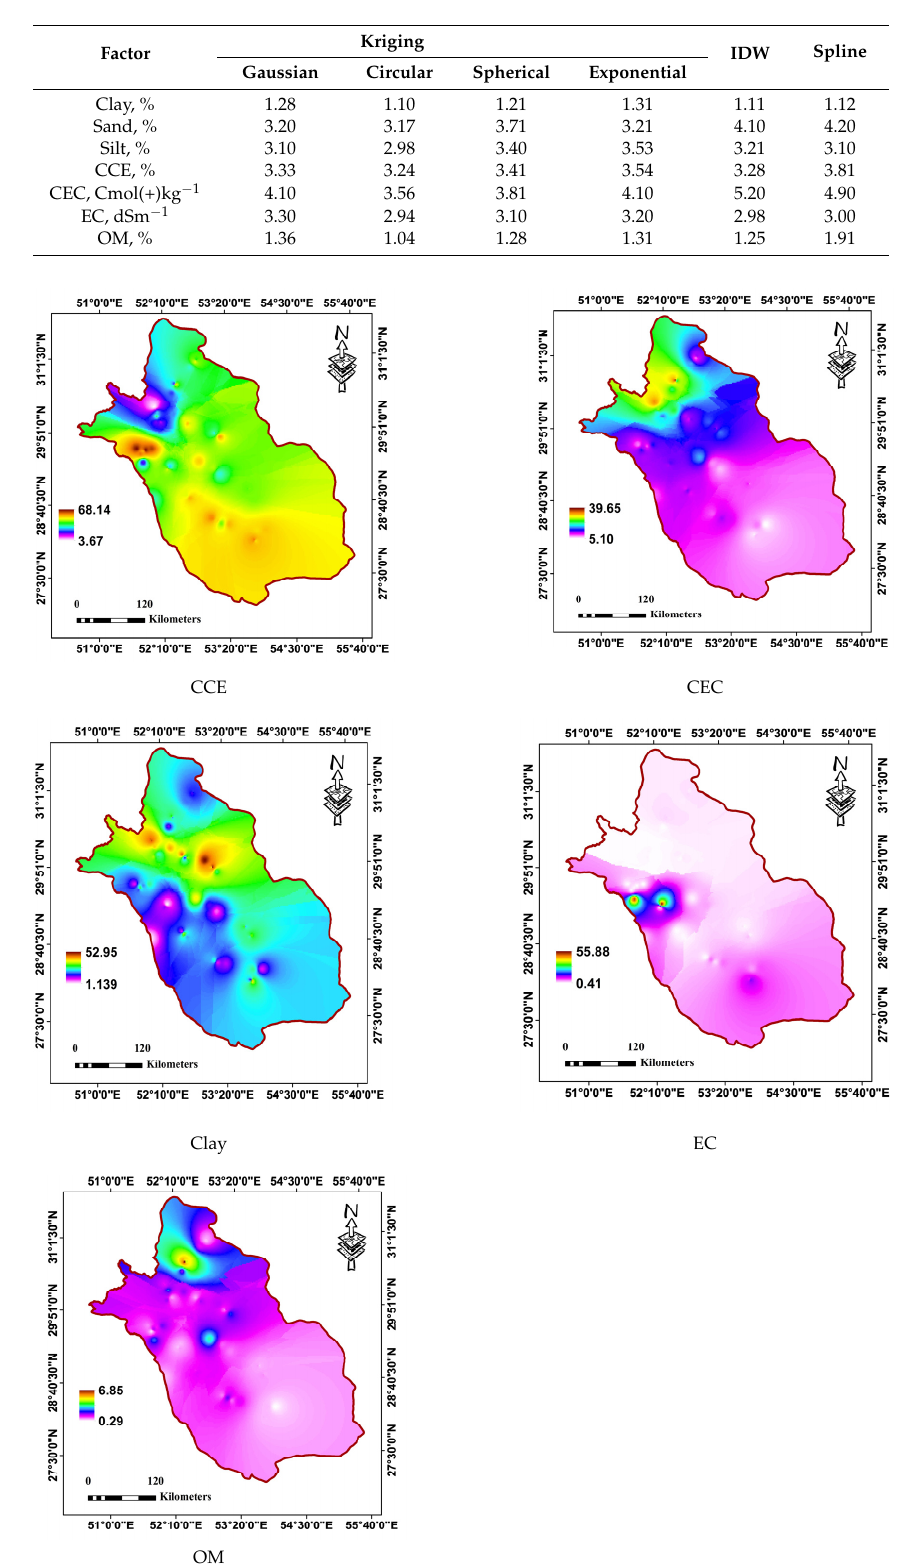
Table 2. Root mean square errors for each parameters by inverse distance weighted (IDW) and kriging methods.